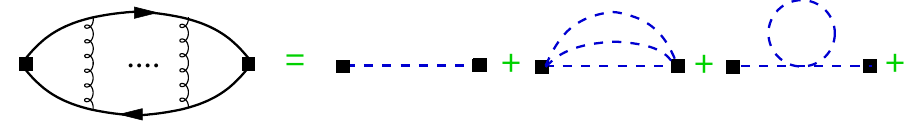
Figure 3. Conventional QCD sum rule [1] preferably applicable to ordinary mesons (blue dashed lines).